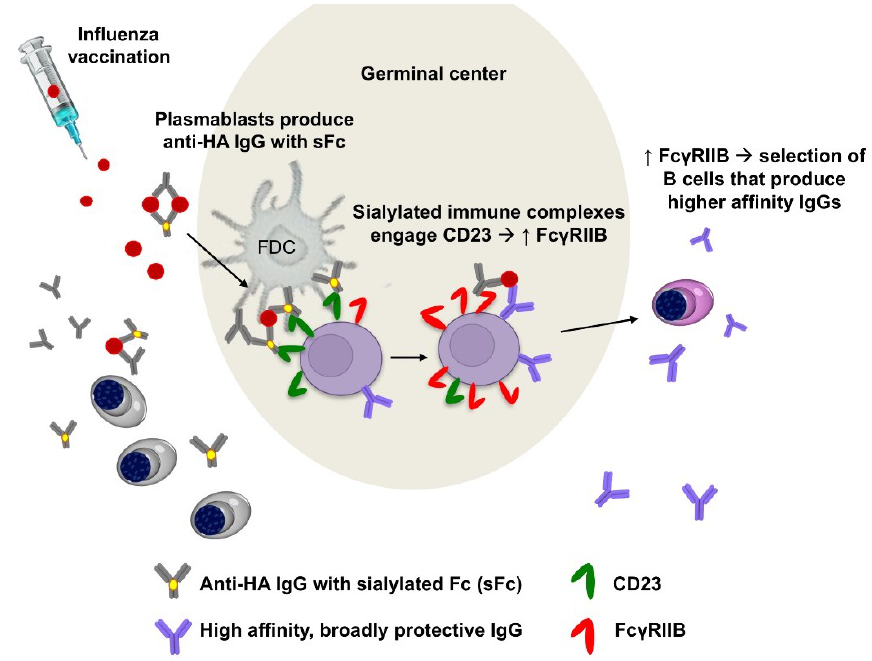
Figure 3. Sialylated IgG immune complexes formed during vaccination enhance affinity of the B cell repertoire. In humans, vaccination with the seasonal influenza virus vaccine triggers production of sialylated anti-HA IgGs (sialylated IgGs are likely produced by plasmambasts, data not shown). Sialylated immune complexes that are formed with vaccine antigens act through CD23 to induce upregulation of FcγRIIB on B cells. Increased expression of B cell FcγRIIb results in selection of higher affinity B cells with increased breadth of protective activity against influenza viruses [8,21].